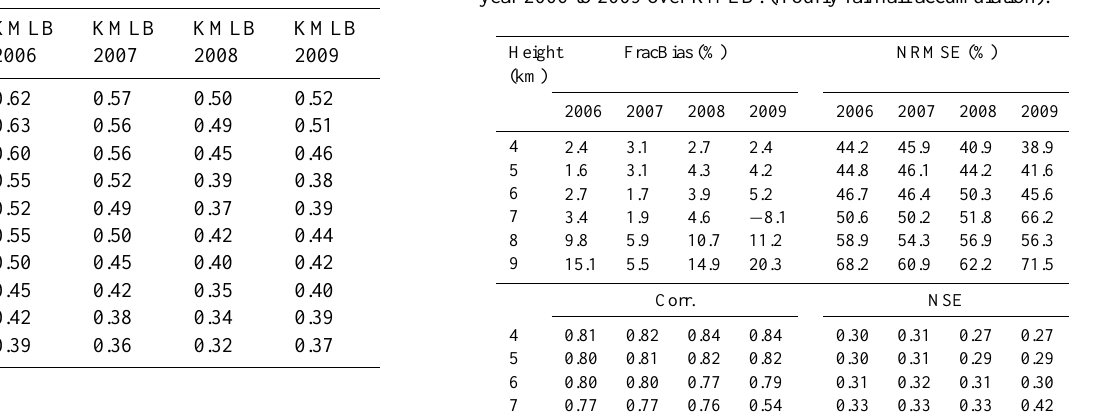
Table 2. Annual correlation between rain gauge and radar reflectiv- ity at different heights (1 to 10km).